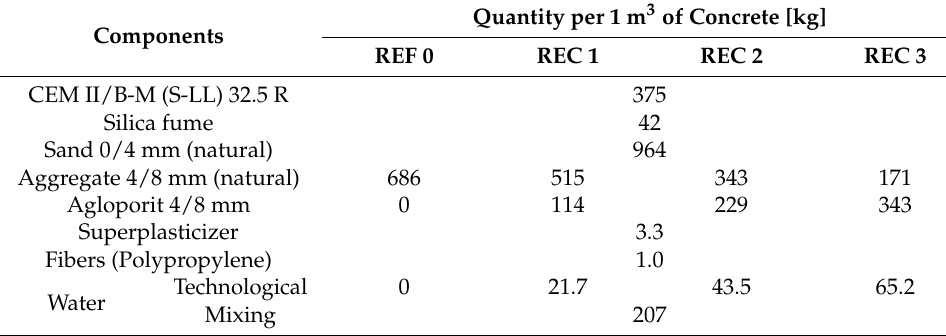
Table 4. Composition of individual concrete